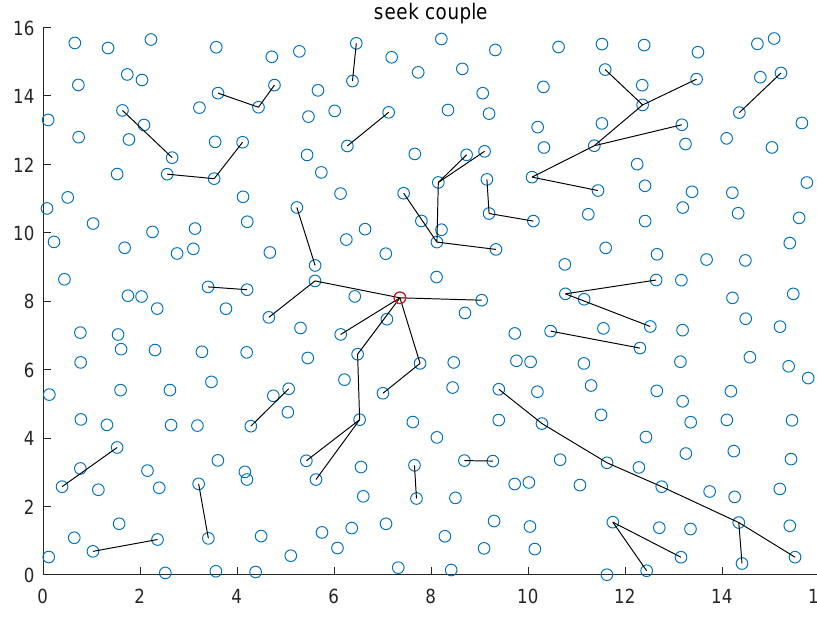
Figure 18. Node Couples the Platform Detects after Finishing Sampling